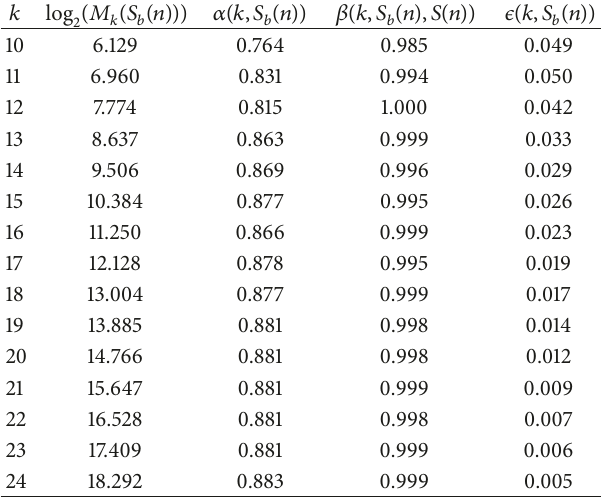
Table 4: log 2 (𝑀 𝑘 (𝑆 𝑏 (𝑛))) , 𝛼(𝑘,𝑆 𝑏 (𝑛)) , 𝛽(𝑘,𝑆 𝑏 (𝑛),𝑆(𝑛)) , and 𝜖(𝑘, 𝑆 (𝑛)) values for generations that 𝑃(𝑛) sequence 𝑏